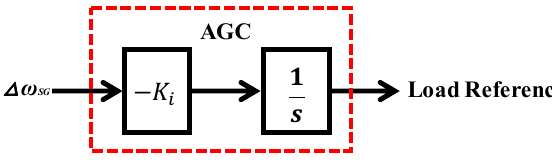
Figure 15. Controller for automatic generation control (AGC).